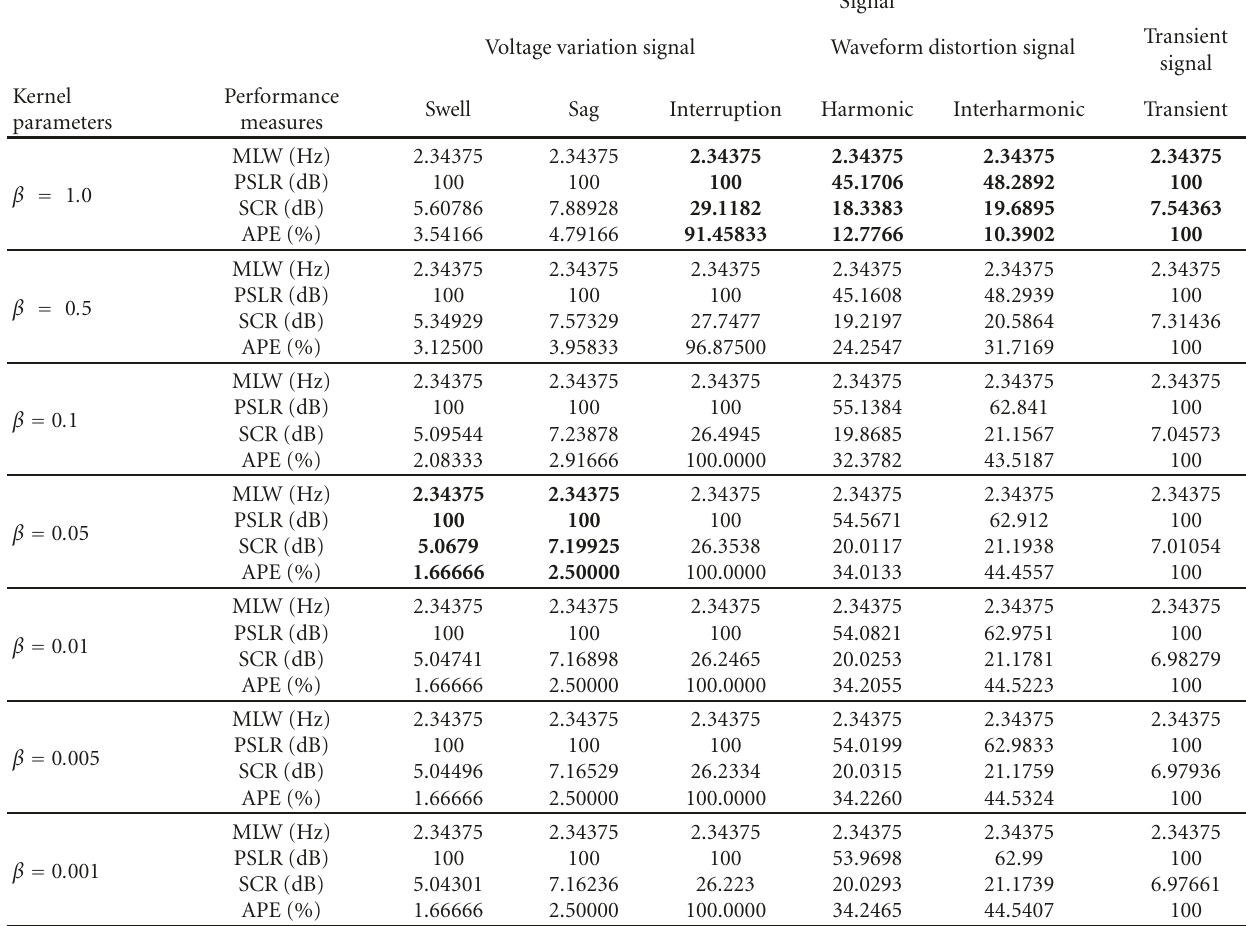
Table 6: Performance comparison of modified